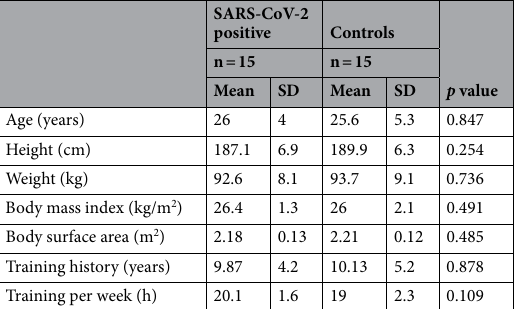
Table 1. Clinical characteristics of the athletes included at the first examination.